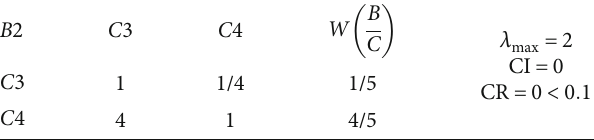
Table 4: Judgment matrix B 2 ~ Ci ð i = 3 ~ 4 Þ